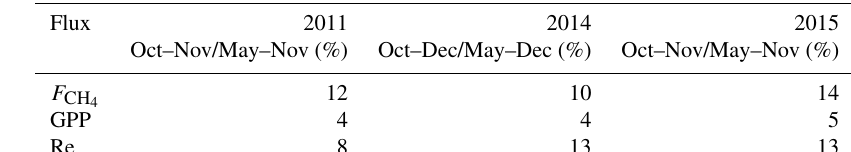
Table 5. Contributions of the non-growing season fluxes to the total measured period.